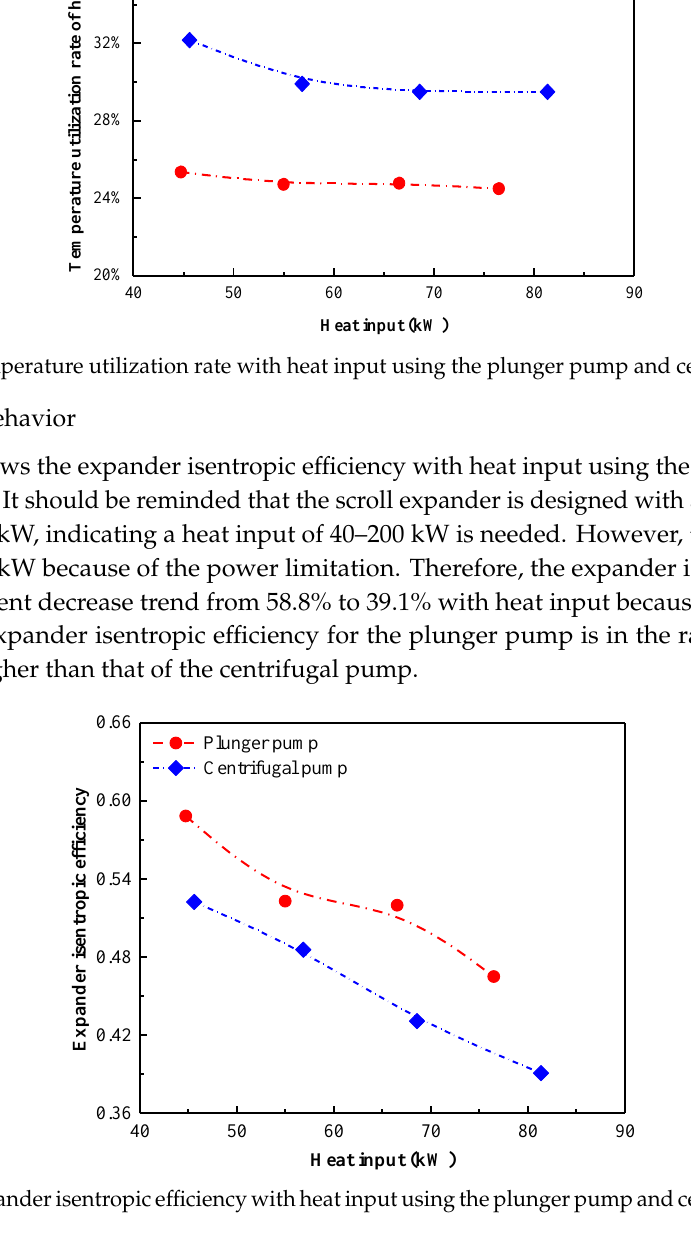
Figure 12. Expander isentropic efficiency with heat input using the plunger pump and centrifugal pump.